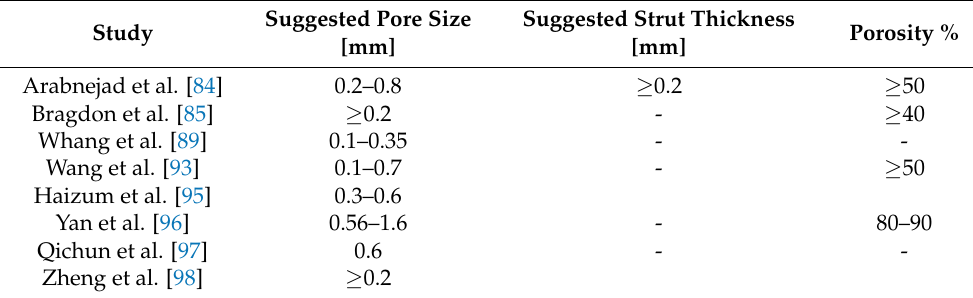
Table 2. A summary of the unit-cell